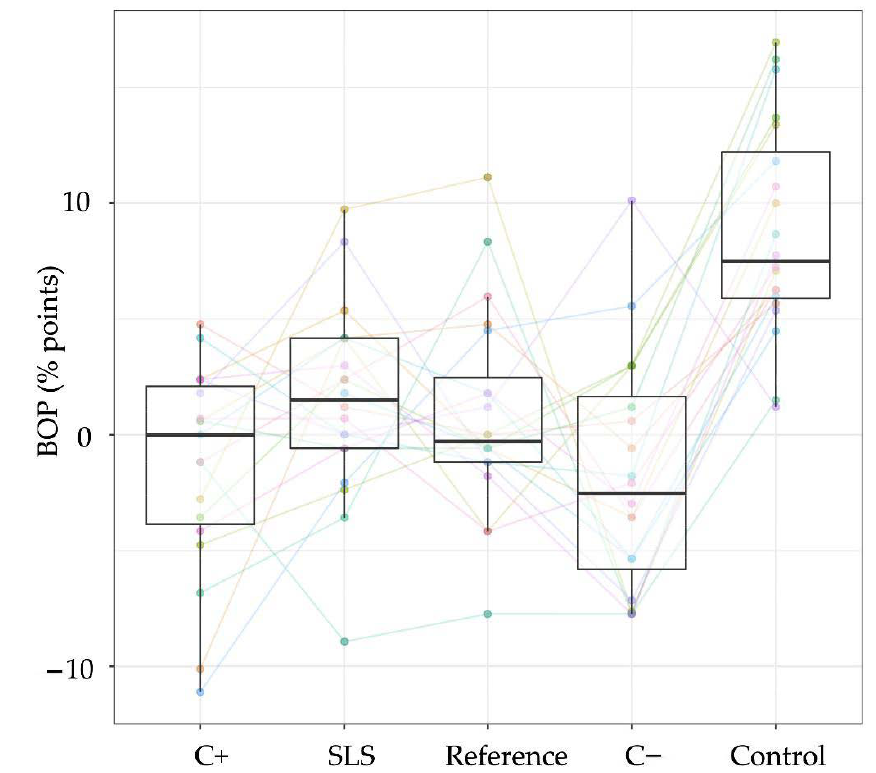
Figure 4. The boxplots of differences in bleeding on probing (BOP) after rinsing and at the baseline of each test toothpaste and the water application are presented for all the subjects ( n = 20, colored), showing median percentages, 25th and 75th quartiles, standard deviation, and outliers. The data of both water runs, which were performed prior to the test phase, were averaged. C+ = enzyme- containing toothpaste with Citrox; SLS = SLS-containing reference toothpaste; placebo = reference toothpaste without SLS and without enzymes; C − = enzyme-containing toothpaste without Citrox; control = mean values after water